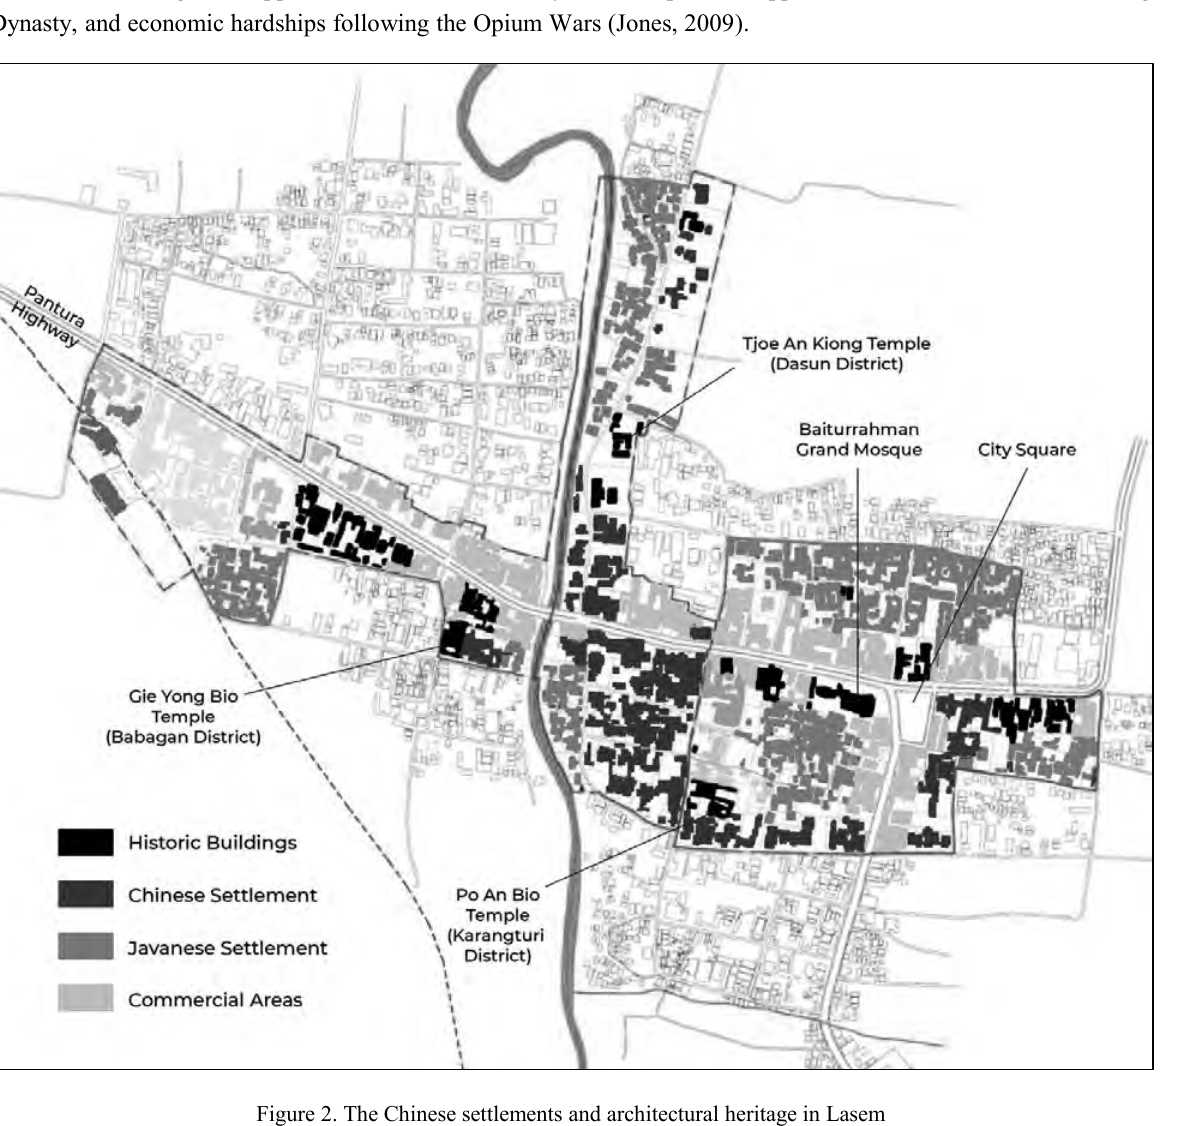
Figure 2. The Chinese settlements and architectural heritage in